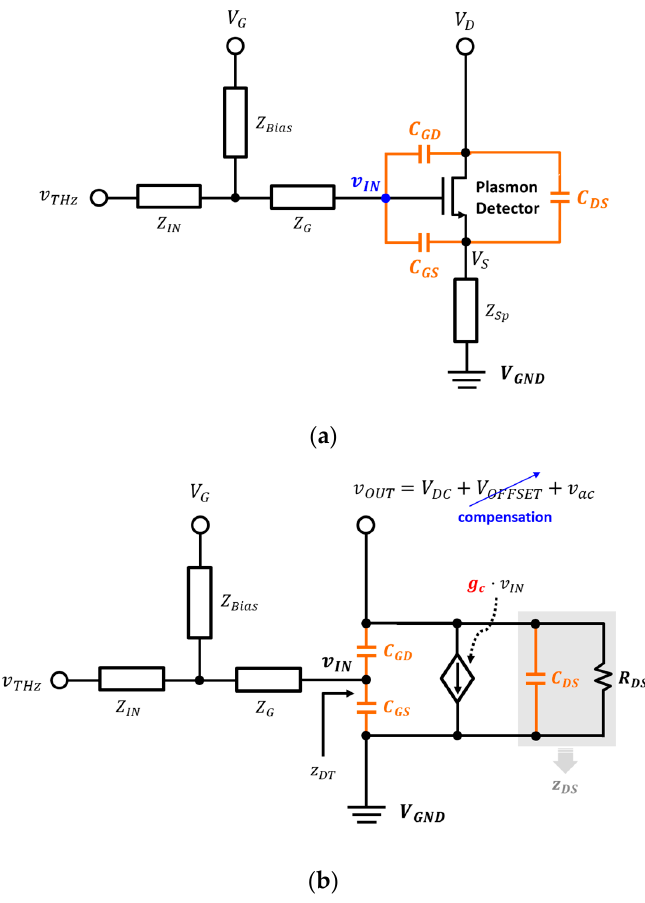
Figure 1. Schematic diagrams of the proposed model for the plasmon detector using the field-effect transistor (FET) at high frequency: ( a ) Basic model including the parasitic capacitances; ( b ) modified model for small-signal analysis.